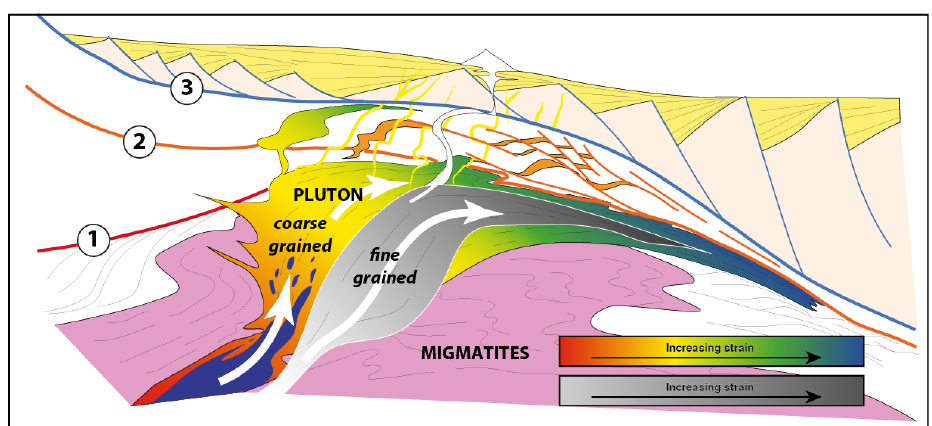
Figure 13. Schematic section showing a conceptual model of the relations between syn-kinematic plutons and the detachments, based on the examples of the Aegean and north Tyrrhenian plutons. Modified from Rabillard et al.